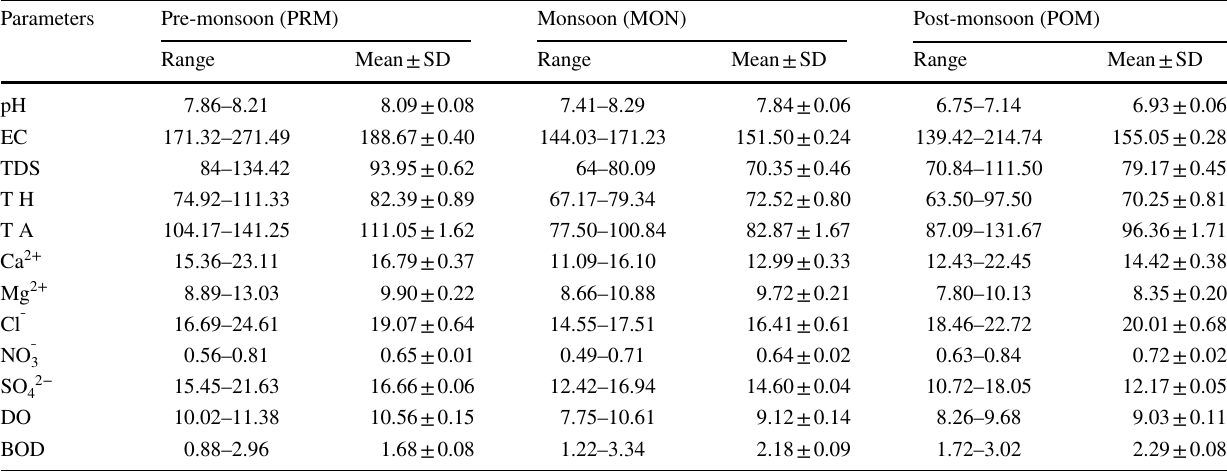
All the parameters are in milligrams per liter except for pH and EC